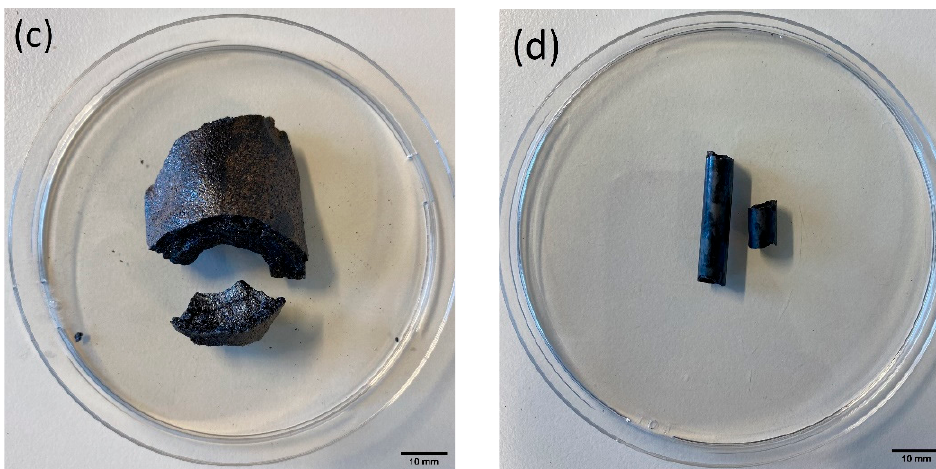
Figure 1. Different kind of samples that were used in the study: ( a ) Ladle slag sample; ( b ) Granular slag sample; ( c ) Dip rod slag sample; ( d ) Laboratory slag sample.